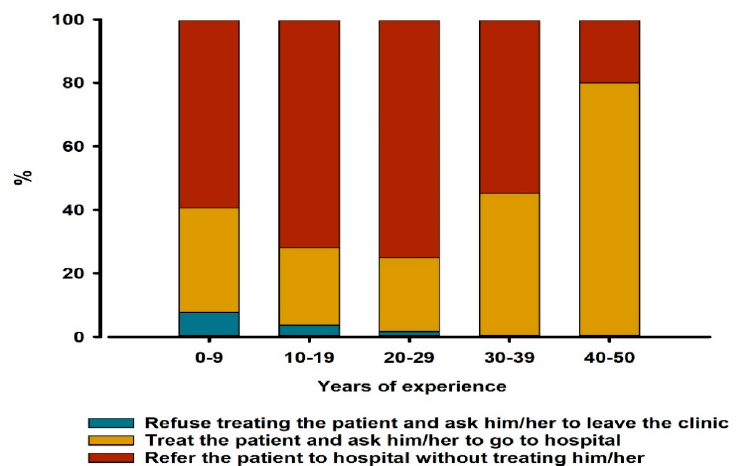
Figure 2. Distribution of different approaches for dealing with suspected COVID-19 patients among dentists with different years of practice ( n = 269). The relation between years of practice and the attitude towards treating suspected COVID-19 patients was assessed by chi-square test ( p = 0.024).